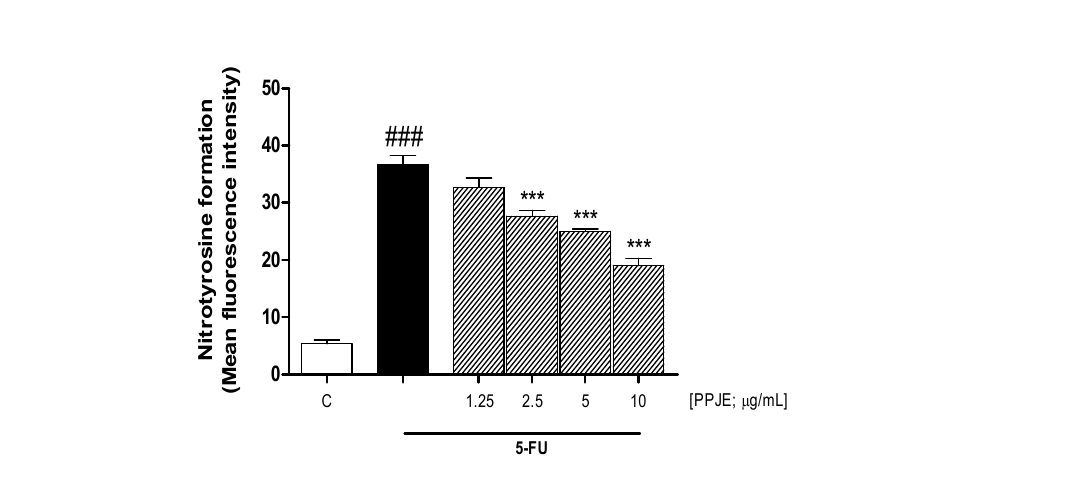
Figure 2. Effect of pomegranate juice extract (PPJE; 1.25–10 µ g/mL) on nitrotyrosine formation, evaluated by cytofluorimetric technique, on HaCaT cells treated with 5-fluorouracil (5-FU; 10 µ g/mL). Data are expressed as mean of fluorescence intensity. C denotes control group. ### denotes p < 0.001 vs. C; *** denotes p < 0.001 vs. 5-FU.